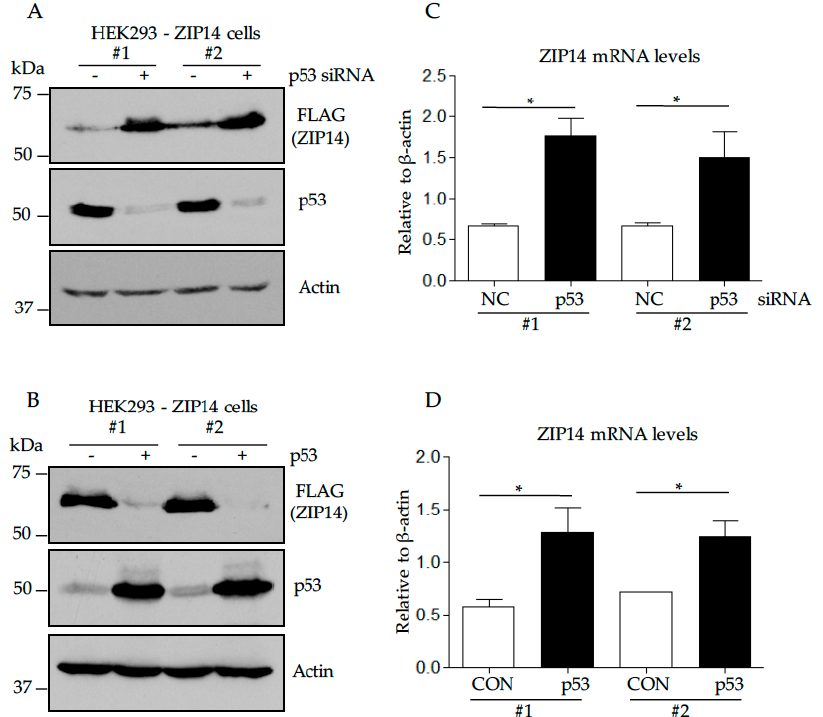
Figure 5. Suppression of p53 increases, whereas overexpression of p53 decreases ZIP14 levels in HEK293 cells stably transfected with ZIP14. HEK293-ZIP14-Stable cells were used in ( A – D ). Clone #1 and clone #2 indicate different stable cell clones; ( A , C ) cells were treated with negative control (NC) or p53-targeting siRNA for 48 h; ( B , D ) cells were transfected with empty vector (CON) or p53-encoding plasmid for 48 h. Lysates were analyzed by immunoblotting for ZIP14, p53 and β -actin ( A , B ). Transcript levels of ZIP14 after p53 siRNA transfection were measured and normalized to those β -actin ( C , D ). Data represents three independent experiments. * p < 0.05, compared with control.